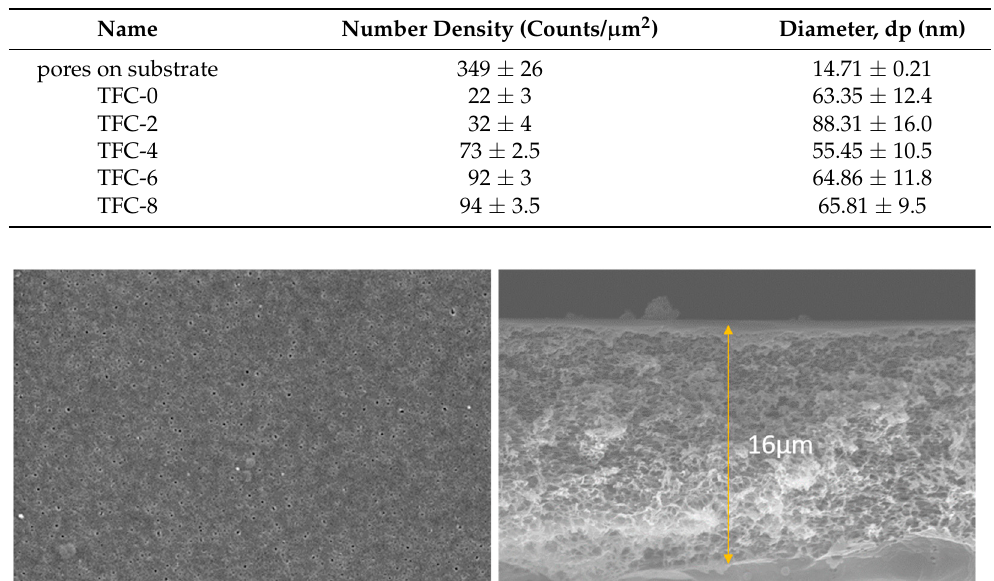
Table 1. Base film pore size and back opening.